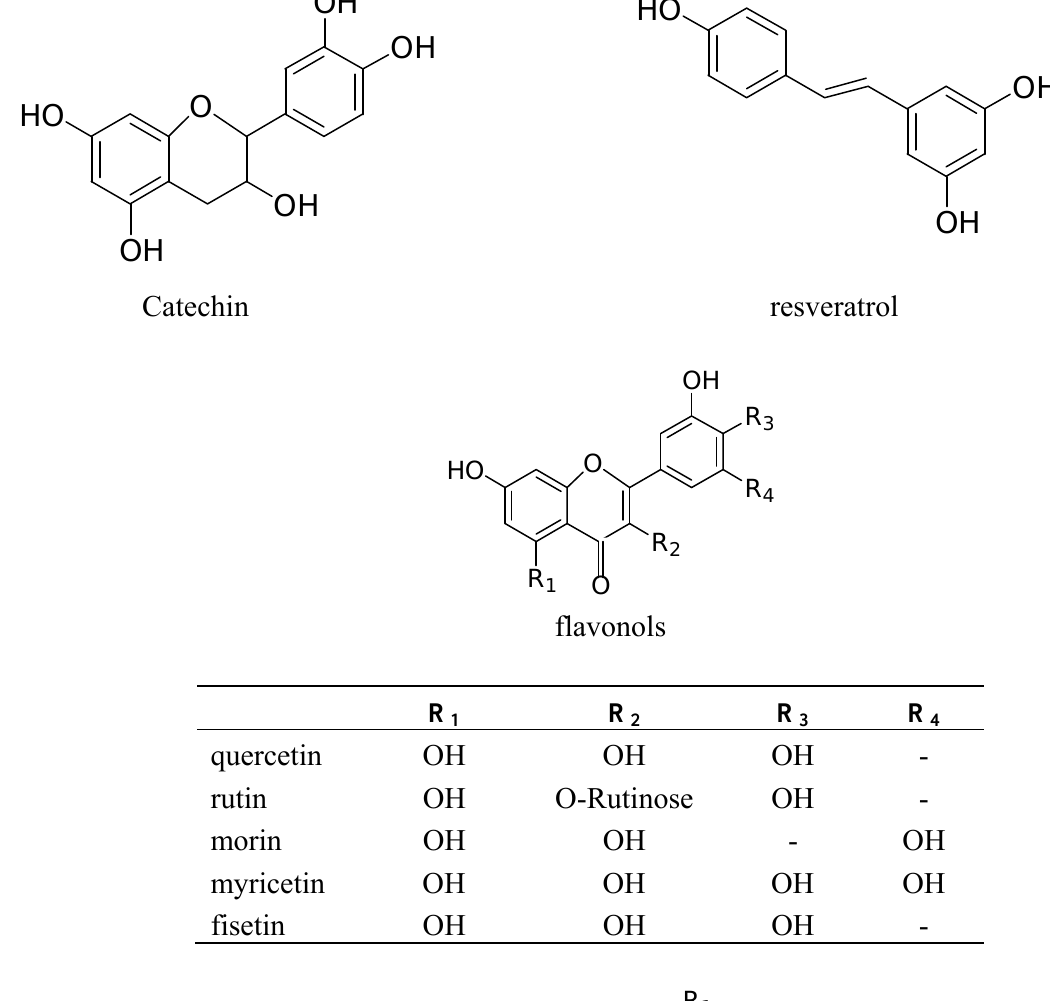
Figure 1. The chemical structures of some phenolic compounds from grapes.